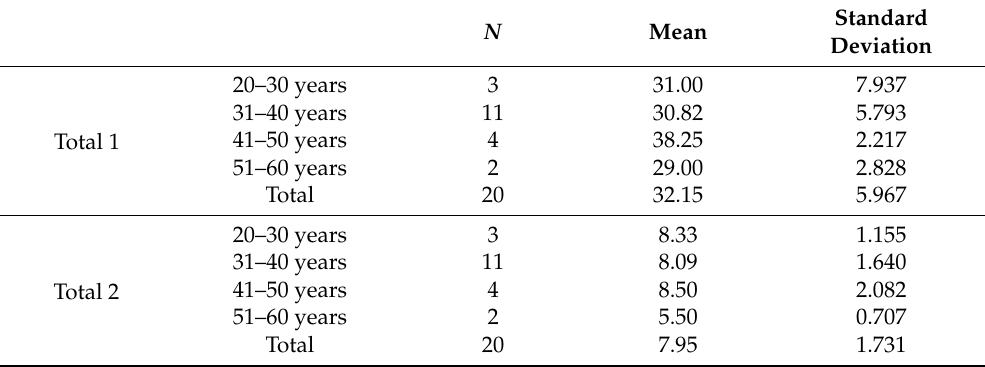
Table 4. Independent samples